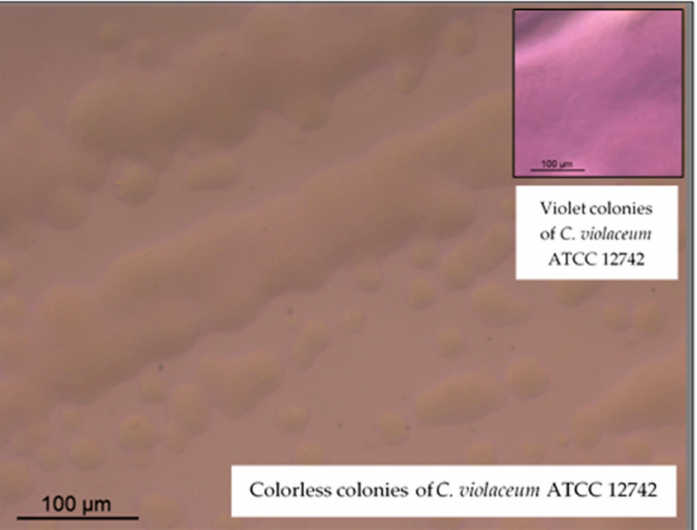
Figure 2. Optical microscopy images showing the inhibition of the violacein pigment production (magnification: 100 × ).